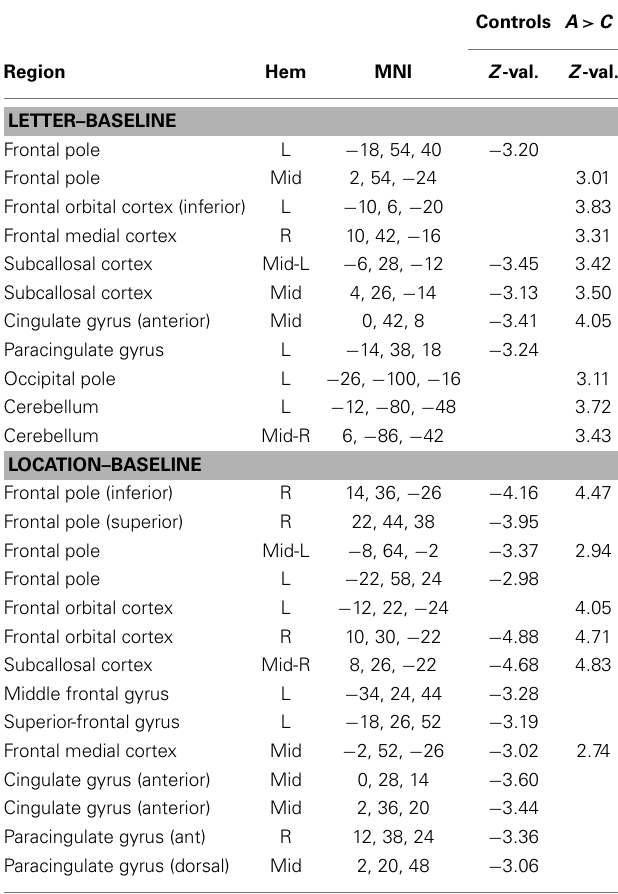
Table 9 |Task behavioral accuracy association with BOLD signal